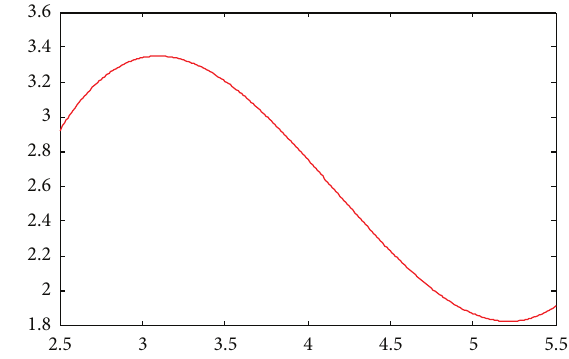
Figure 6: The diagram of Malmquist product index DMU 6 .